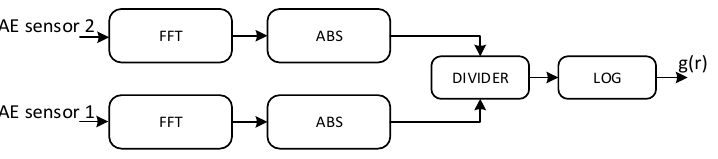
Figure 8. g ( r )-construction. FFT, fast Fourier transform.